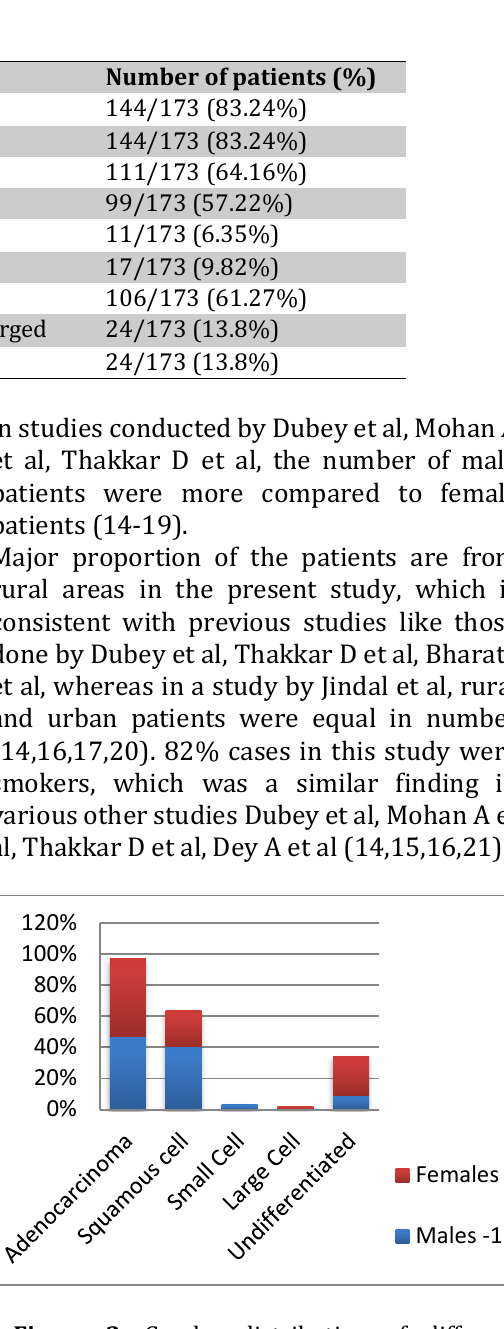
Figure 2. Gender distribution of different histologies of lung cancer .